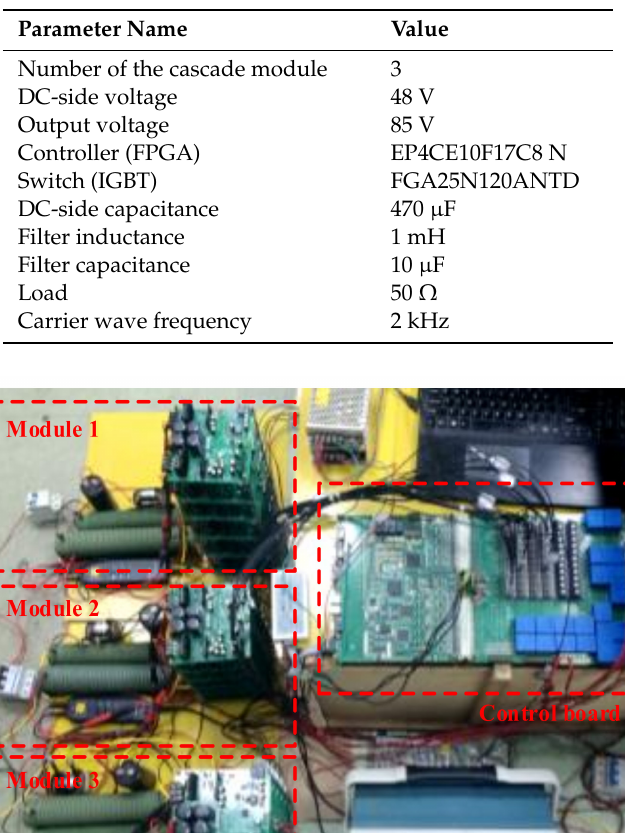
Table 3. Experiment parameters.